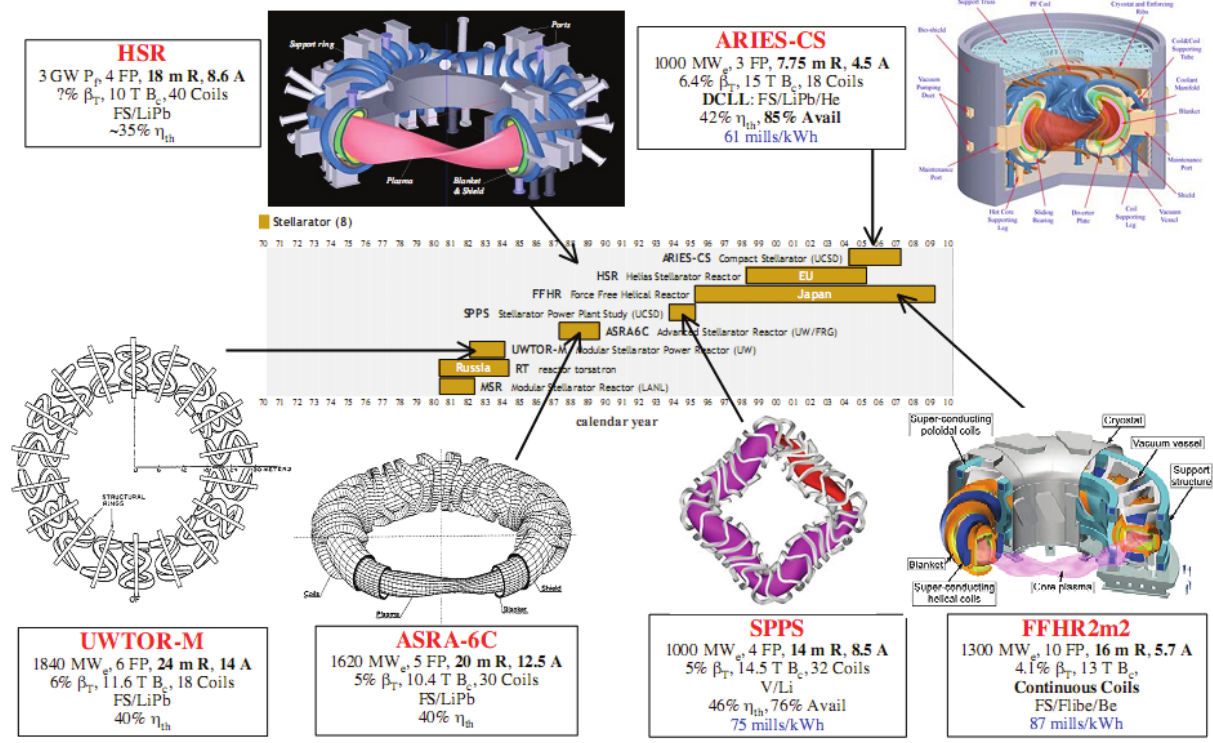
Figure 4. Timeline and main features of stellarator power plant